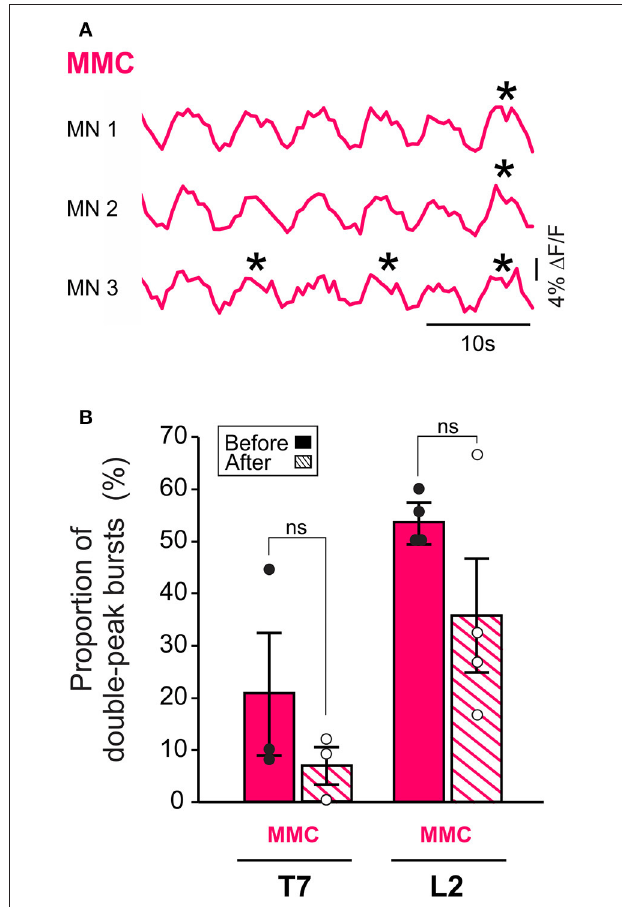
FIGURE 3 | MMC MNs display double-peak bursts during LLA. (A) Changes in fluorescence in three individual MNs in the left MMC (top) and right MMC (bottom). Asterisks indicate double-peak bursts (see Methods). (B) Bar graphs showing the mean frequency of occurrence of double-peak bursts in MMC MNs of T7 and L2 before (solid bars) and after (hatched bars) removal of the brain stem. Each bar is a grand average across all experiments (individual